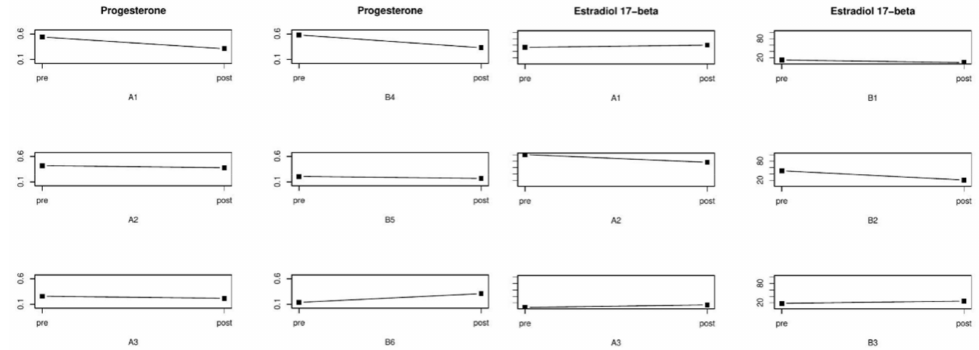
Figure 7. Concentration of progesterone and estradiol 17-beta in patients in subgroups A and B before and after treatment. Abbreviations: A1, A2, A3, B1, B2, B3—patient designation, NPRS—Numeric Pain Rating Scale, Pre—result before treatment, Post—result after